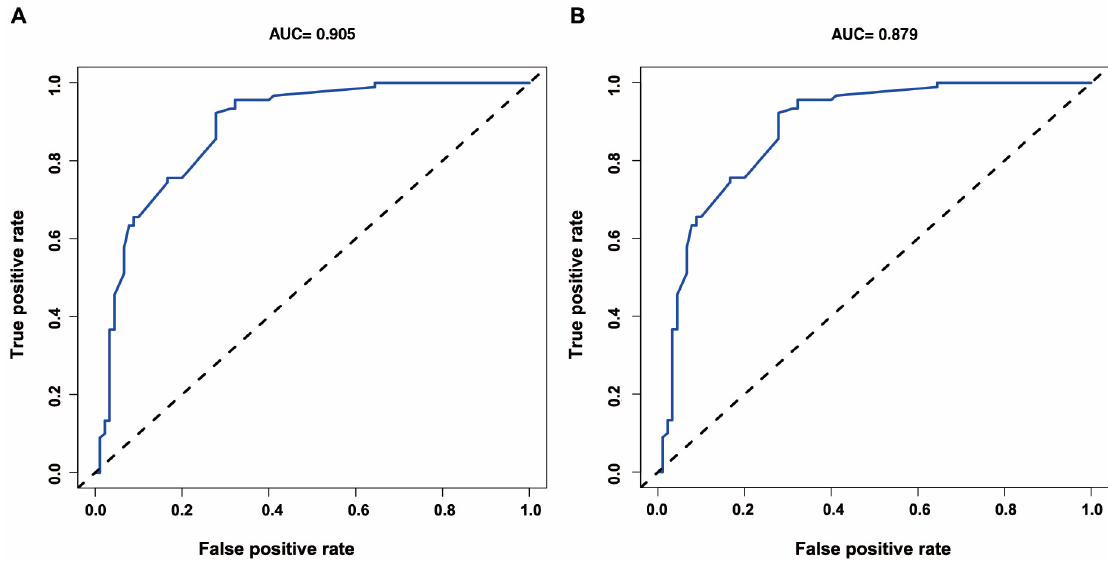
Figure 4. ROC curves validating the discrimination power of the nomogram (( A ) training; ( B ) bootstrapping). Abbreviations: AUC (area under the curve).